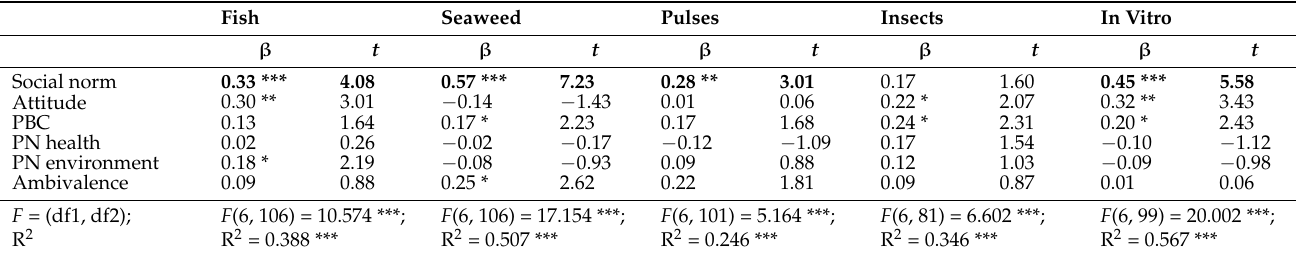
Table 4. Hierarchical regression analyses for the difference scores (2019–2015) with the drivers as independent variables and intention as the dependent